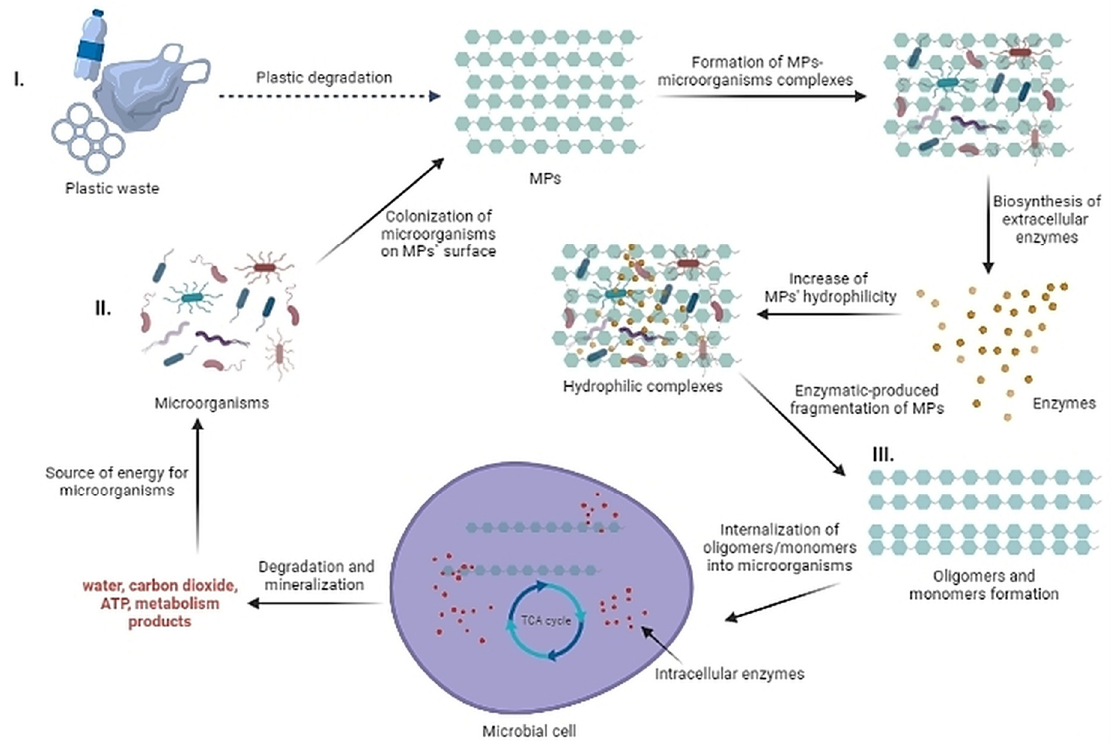
Figure 3. Biodegradation process of MPs by microorganisms. ( I ) Plastic waste is degraded to microplastics. ( II ) Microorganisms colonize the MPs’ surface and produce extracellular enzymes which degrade MPs to monomers and oligomers. ( III ) Monomers and oligomers are internalized into microbial cells, and under the action of intracellular enzymes, these are disintegrated to metabolic products, which are used as a carbon source by microorganisms. Image created in https://biorender.com/ (accessed on 4 August 2022).